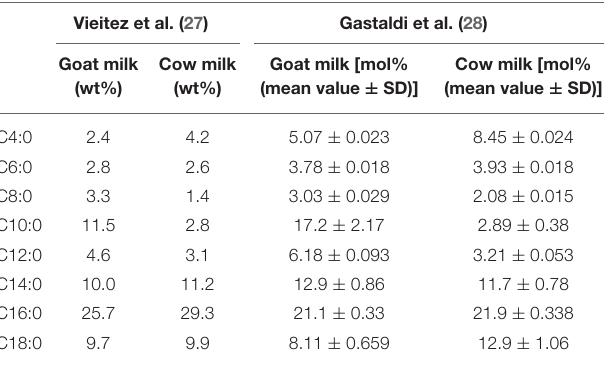
TABLE 2 | Comparison of different triglycerides content of goat milk and cow milk. Vieitez et al.